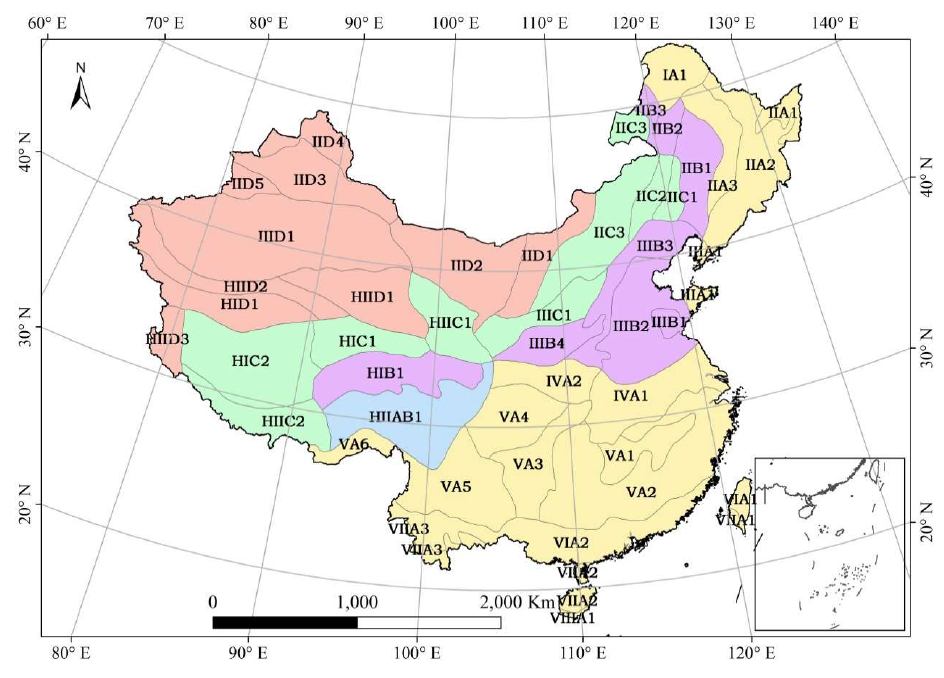
Figure 3. The topographic zones over Mainland China.